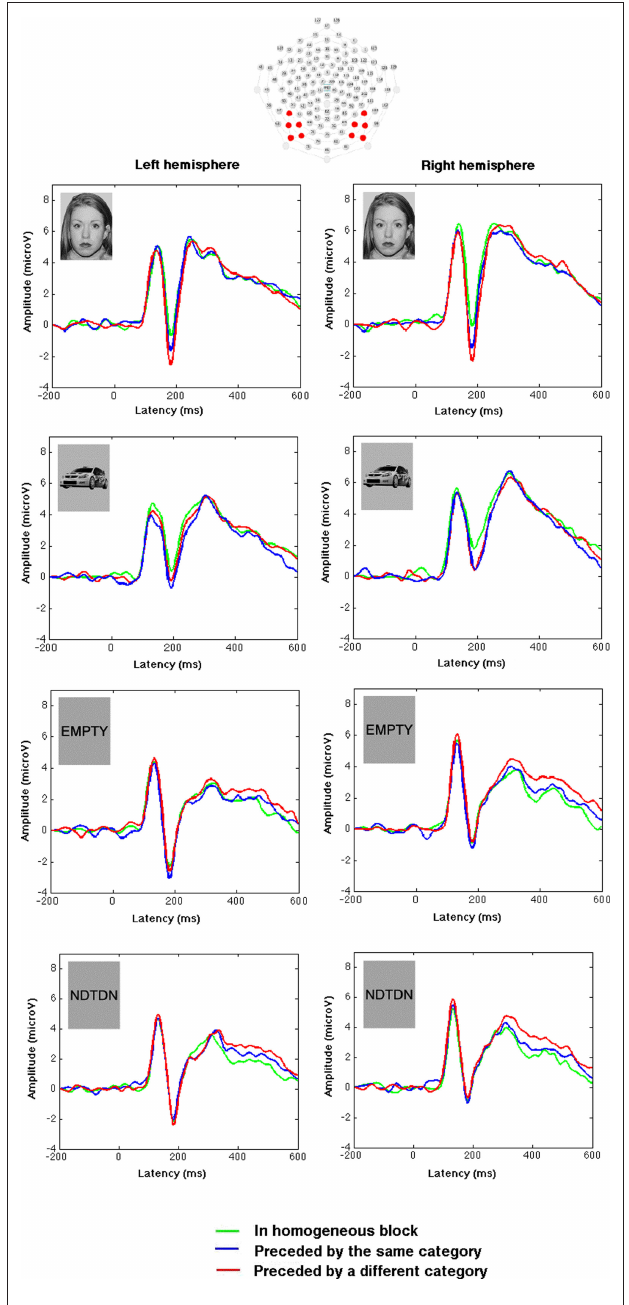
Figure 1 | grand average waveforms in the left and right occipitotemporal regions (channels: 58, 64, 65, 68, 69, 89, 90, 94, 95, 96) for faces, cars, words, and non-words in three presentation conditions: in homogeneous blocks, in mixed blocks when preceded by a stimulus of the same category (Mixed PrSame), or in mixed blocks when preceded by a stimulus of another category (Mixed PrOther). These waveforms are based on all trials included for analyses (see Materials and Methods) in each experimental